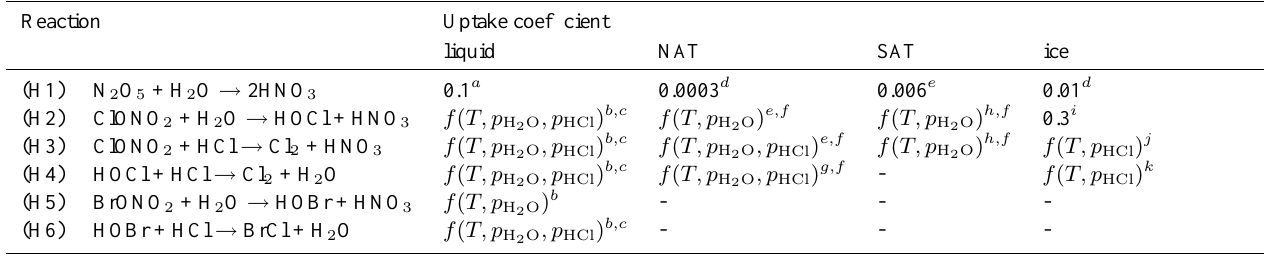
Table 4. Heterogeneous reactions included in the model Reaction Uptake coefficient liquid NAT SAT ice (H1) 0.0003 d 0.006 e